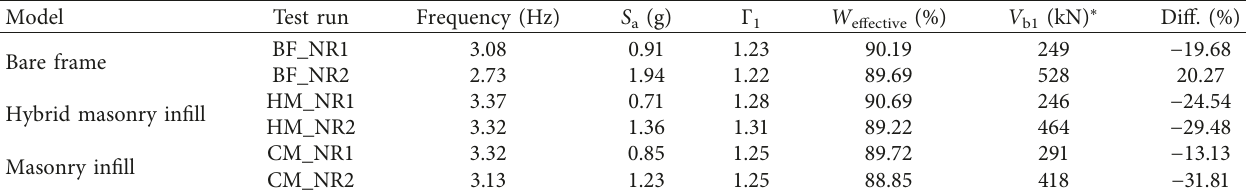
Figure 16: Seismic response curves developed for the prototype of test models. Table 4: Base shear force demands for models calculated from the 5% damped elastic acceleration spectrum generated for input